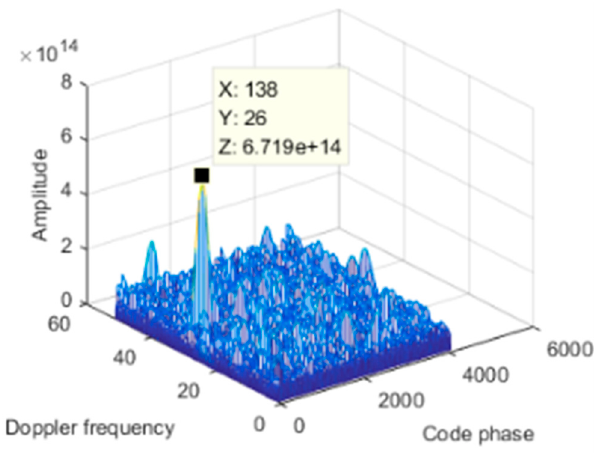
Figure 24. Acquisition result.